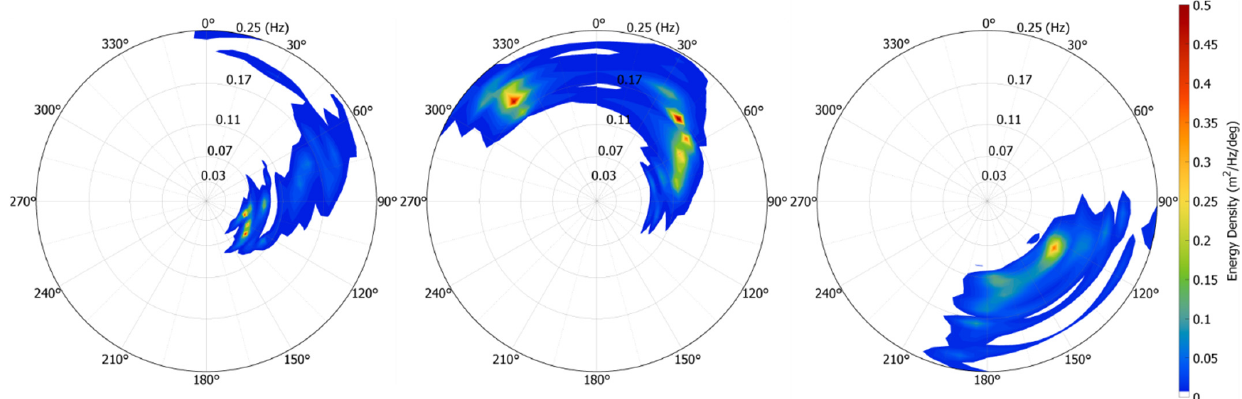
Figure 9. Polar spectra showing the wave energy directional distribution recorded by the ILM2 wave buoy before ( left , 15:00 UTC 13 September 2018), during ( center , 08:30 UTC 14 September 2018), and after ( right , 02:00 UTC 15 September 2018) Hurricane Florence passed over the ILM2 buoy.